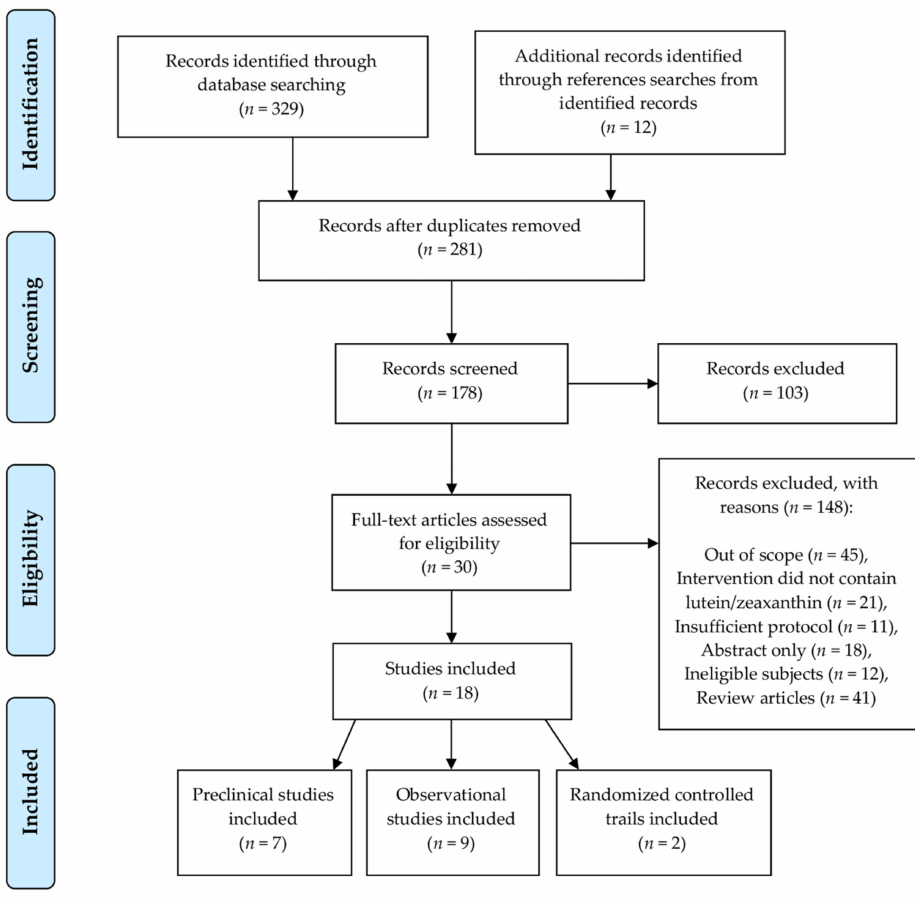
Figure 2. Flow diagram of literature search and selection criteria.